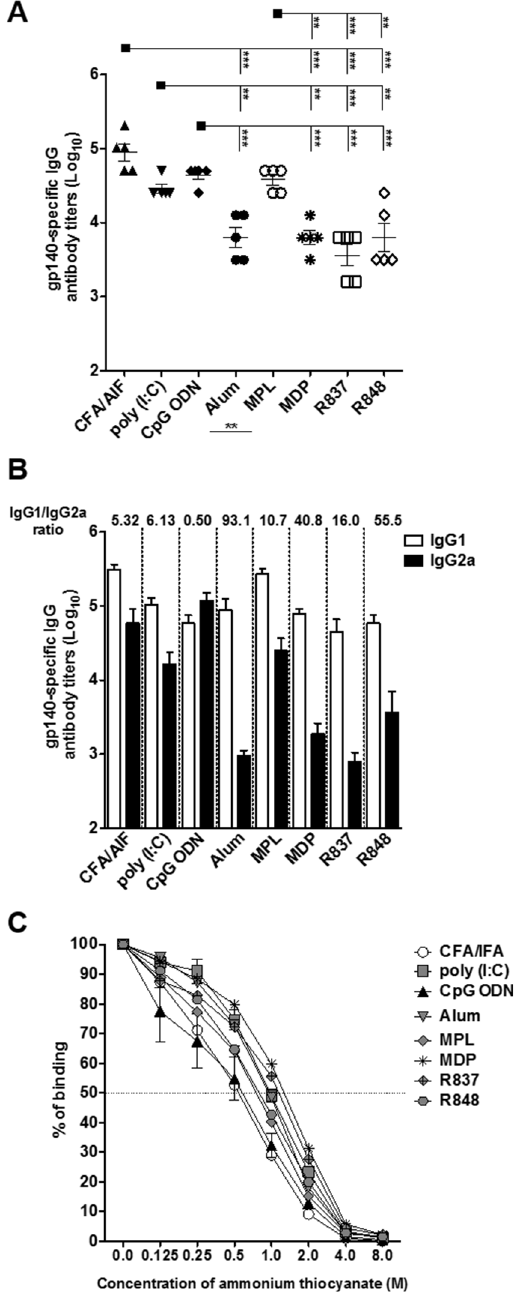
Fig 1. Immunization with Env HIV-1 gp140 trimer is able to elicit high-affinity specific antibody titers in the presence of different adjuvant formulations. BALB/c mice (n = 5 per group) received 2 doses with 10 μ g of gp140 via s.c in the presence of the adjuvants CFA/IFA, poly (I:C), CpG ODN, alum, MPL, MDP, R837 or R848. Fifteen days after last dose, serum was collected and individually analyzed by ELISA. (A) Total gp140-specific IgG antibody titers on a logarithmic scale; (B) Specific IgG subtypes; (C) Antibody affinity was determined by ELISA with increasing concentrations of the chaotropic agent ammonium thiocyanate. ** p < 0,01; *** p < 0,001. Data represent mean ± SD.